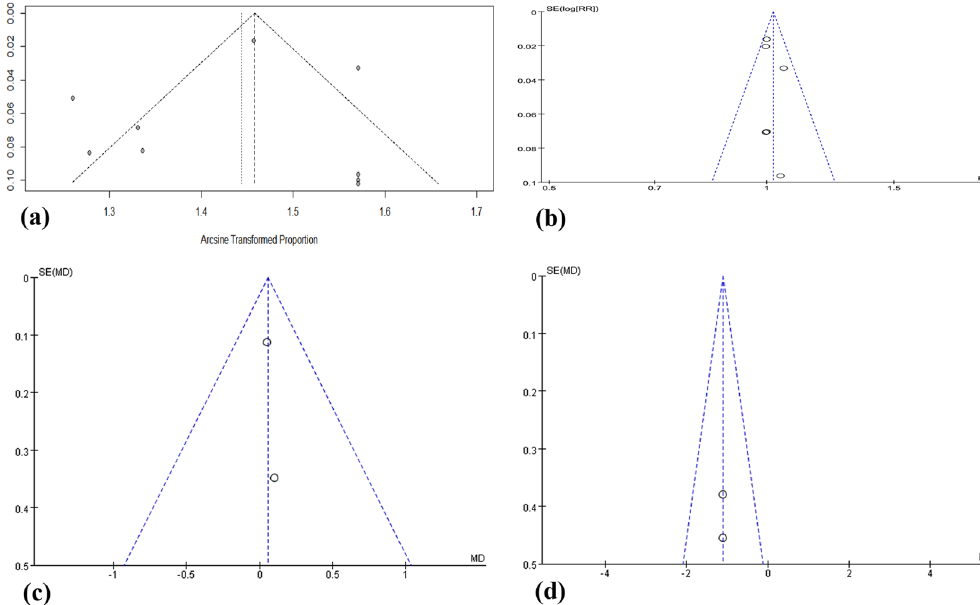
Figure 5. Funnel plots. ( a ) Funnel plot of survival rates in non-controlled studies. ( b ) Funnel plot of survival rates in controlled studies. ( c ) Funnel plot of MBL at 36 months. ( d ) Funnel plot of EsBG at 12